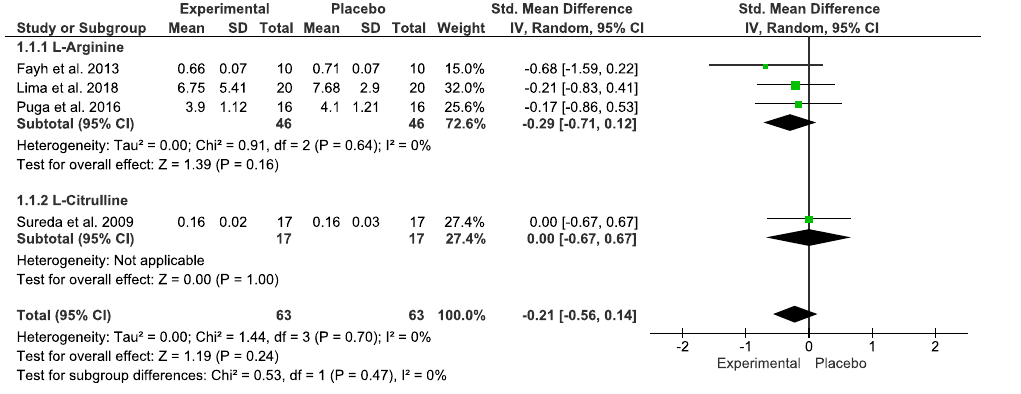
Figure 3. Effects of L-Arginine and L-Citrulline on oxidative stress markers [14,16–18].